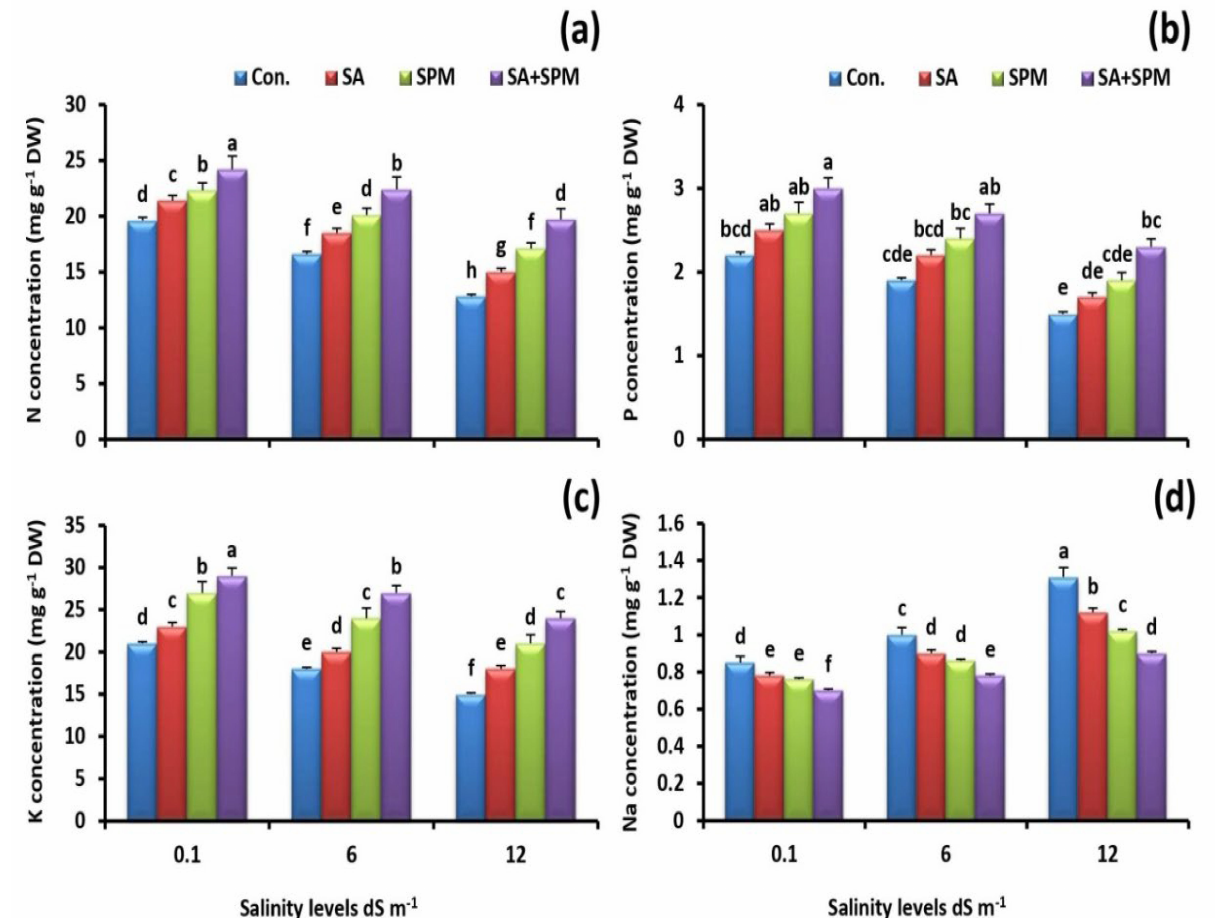
Figure 3. Effect of salicylic acid (SA) and/or spermine (SPM) foliage applications on the concentration of ( a ) nitrogen (N), ( b ) phosphorus (P), ( c ) potassium (K), and ( d ) sodium (Na) in grains of wheat plants exposed to non-saline and saline (6.0 and 12.0 dS m − 1 ) conditions. The results showed the mean ± SE of four replicates. Different letters indicate significant differences at ( p < 0.05) level according to Duncan’s